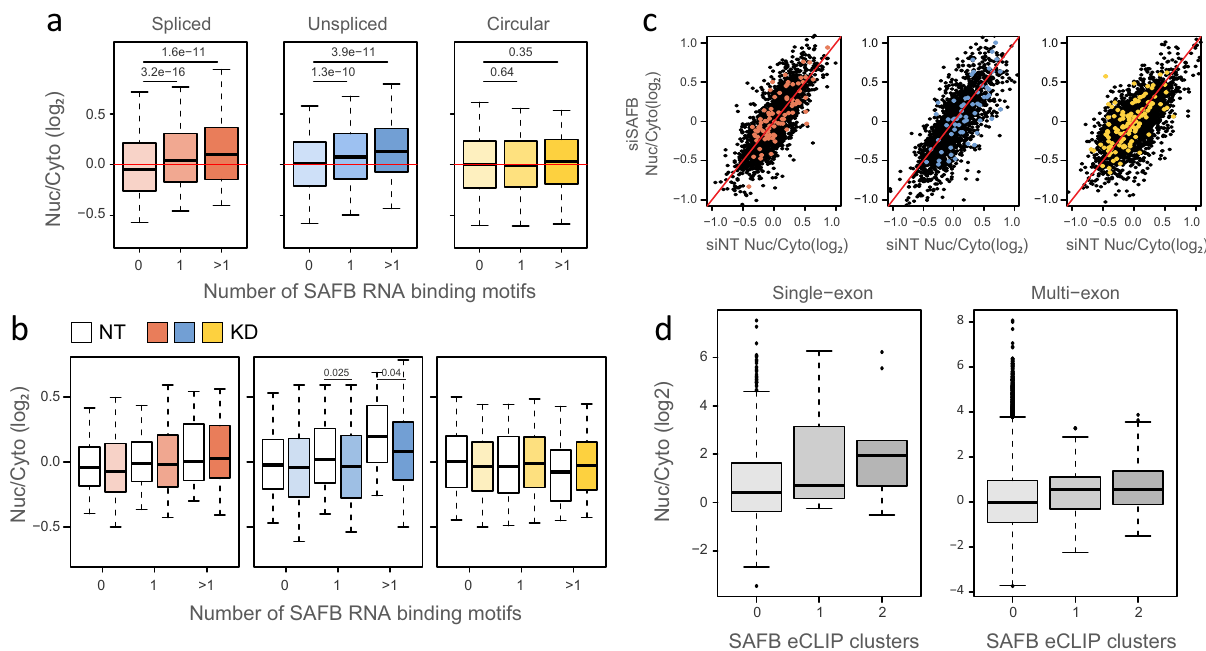
Fig. 4 The effect of SAFB KD. a Nuc/Cyto ratios of tiles with the indicated number of SAFB motifs in each context; spliced (red), unspliced (blue), and circular (yellow). n = 3 biologically independent samples. Box plots show median, fi rst to third quartile, whiskers are 1.5× interquartile range. P -values were computed using two-sided Wilcoxon rank-sum test. b Nuc/Cyto ratio of tiles with the indicated number SAFB motifs following transfection of NT control (white) and siSAFB (colored as in a ). n = 3 biologically independent samples. Box plots are as in ( a ). P -values were computed using two-sided Wilcoxon rank-sum test. c The effect of factors depletion on subcellular localization; Nuc/Cyto ratio of tiles in SAFB KD samples vs. NT control samples of all tiles (black), and tiles that have > 1 motif (colored). Red line indicates X = Y. d Subcellular localization of single-exon and multi-exon transcripts annotated in RefSeq, harboring 0, 1 or more than 1 SAFB eCLIP clusters in ENCODE project RNA-seq data from HepG2 cells. n = 1004, 7, and 9 for single-exon and n = 42002, 134, and 185 for multi-exon transcripts. Source data are provided as a Source data fi